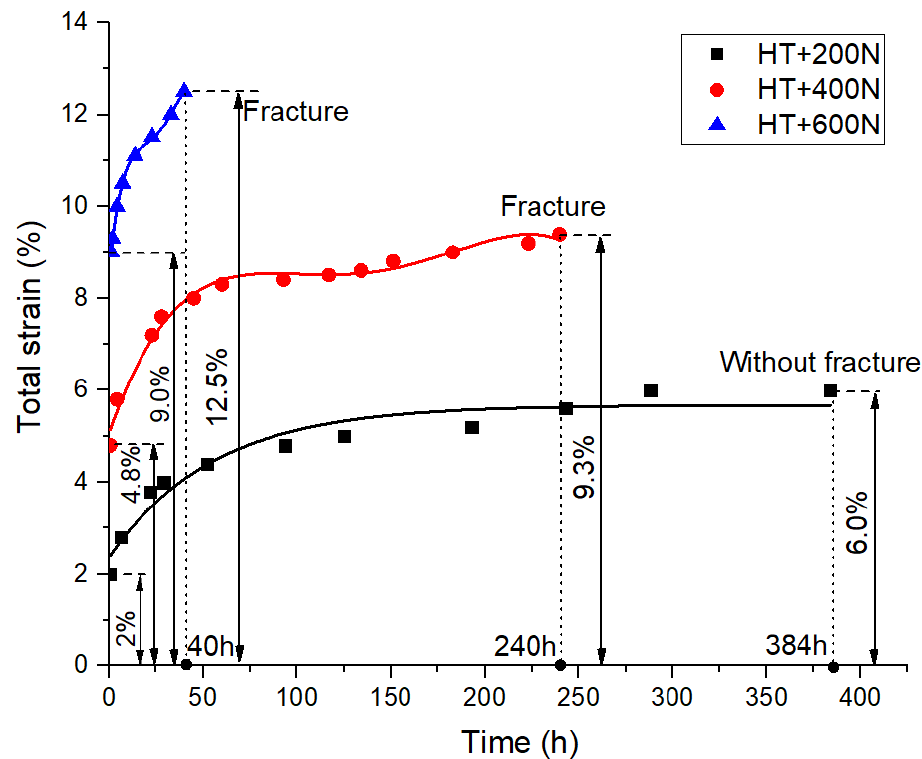
Figure 4. Creep curves in the HT environment.